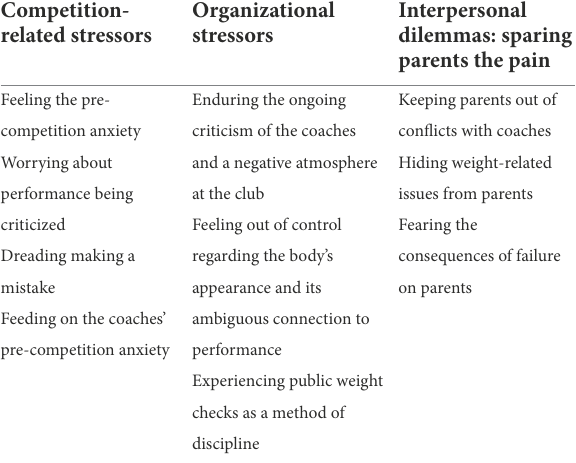
TABLE 1 Summary of the themes and subthemes of the stressors experienced by athletes . Competition- related